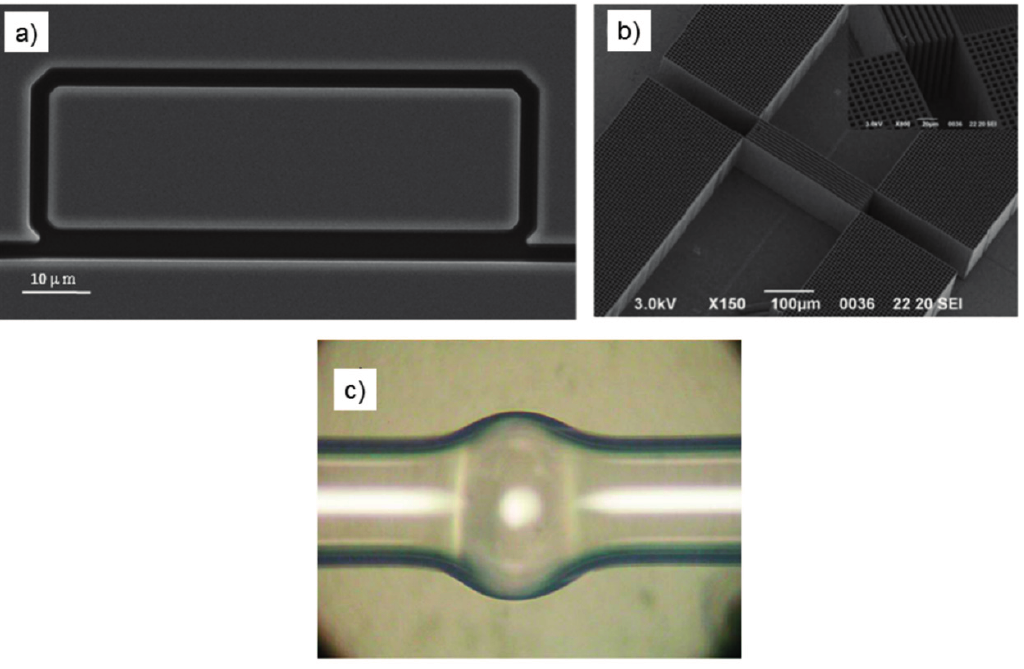
Figure 5. SEM image of ( a ) the integrated optofluidic ring resonator based on liquid ARROWs. Reprinted with permission from [69] (Copyright (2010) AIP); ( b ) PhC-OFM with PhC structure height and width of 90 μ m and 130 µm, respectively. In the image are also shown the fiber grooves. Reprinted with permission from [74] (Copyright (2012) RSC Publishing); ( c ) Optical image of microbubble with outer diameter of ~340 μ m. (Reprinted with permission from [77] Copyright (2011)